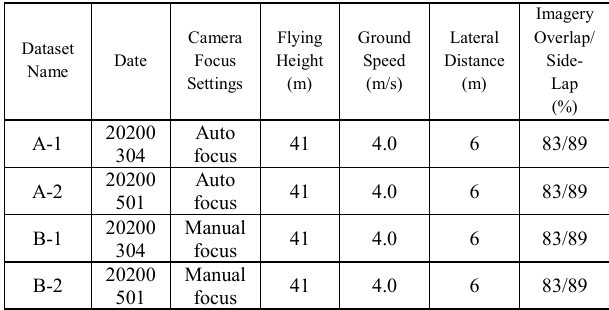
Table 1. Flight configurations and camera focus settings for the flight missions captured for the experimental datasets